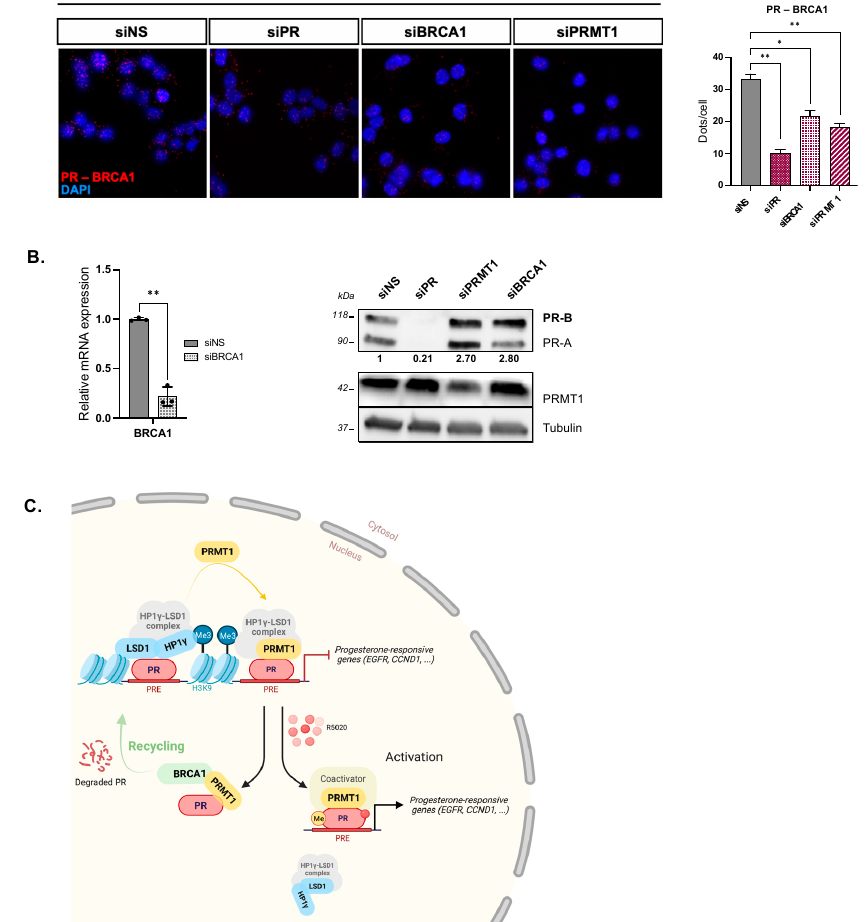
Figure 4. PRMT1 regulates PR–BRCA1 interactions in unstimulated T47D breast cancer cells. T47D cells were cultured in medium deprived of steroids for 48 h and then starved in serum-free medium for 24 h. ( A ) Proximity ligation assay (PLA) was used to detect endogenous interactions between PR and BRCA1 in T47D cells. Cells were transfected with non-silencing control siRNA (siNS) or with anti-PR (siPR), anti-PRMT1 (siPRMT1), or anti-BRCA1 (siBRCA1) siRNAs and anti-PR and anti-BRCA1 antibodies were used. (Left panel): The nuclei were counterstained with DAPI (blue) (Obj: X60). The interactions are represented by red dots. (Right panel): The graph shows the quantification of the number of signals per cell, as described in the Methods section. The mean ± SD of three independent experiments is shown. The p-value was determined using the Student’s t -test: * indicates p ≤ 0.05 and ** indicates p ≤ 0.01. ( B ) The efficacy of the different siRNA treatments in unstimulated T47D cells was analyzed by qPCR (left panel) and IB (right panel). Tubulin was used as a loading control. The ratio (PR-B expression/tubulin expression) was used to quantify PR expression in the different conditions. ( C ) Proposed model: PRMT1 interacts with unliganded PR and some partners as part of a genomic repressive complex regulating the expression of a subset of progestin-responsive genes, including EGFR , STAT5A , or CCND1 , in the absence of hormones. In parallel, we also showed that PRMT1 helps unliganded PRs and the E3 ubiquitin ligase BRCA1 to interact. This interaction may be crucial for the proper and controlled turnover of the receptors and, consequently, helps to finely tune the silencing of progesterone-responsive genes prior to hormonal stimulation. The addition of progestin results in removing the repressive complex from basally repressed promoters and allows the recruitment of PR coactivators, including PRMT1, which methylates the receptor to regulate its stability and its proper transcriptional activation. Created with BioRender.com.